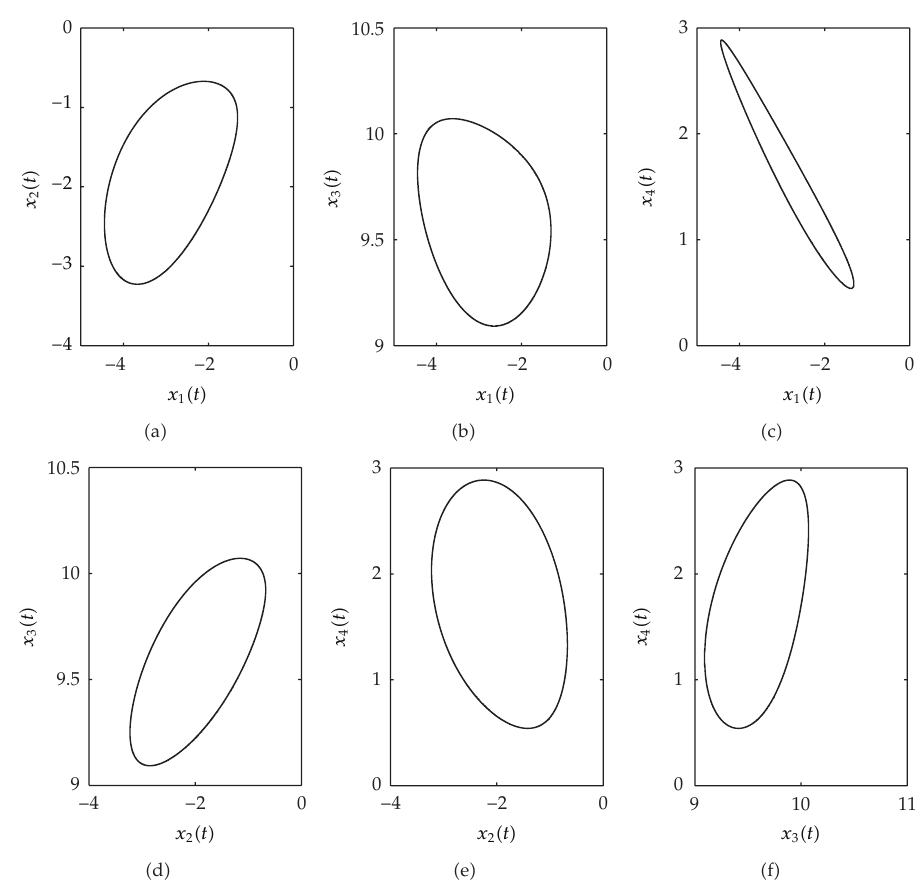
Figure 4: Phase plots for the cyclic case of the hyperchaotic Chen system with a (cid:9) 35 , b (cid:9) 10 , c (cid:9) 1 , d (cid:9) 34.